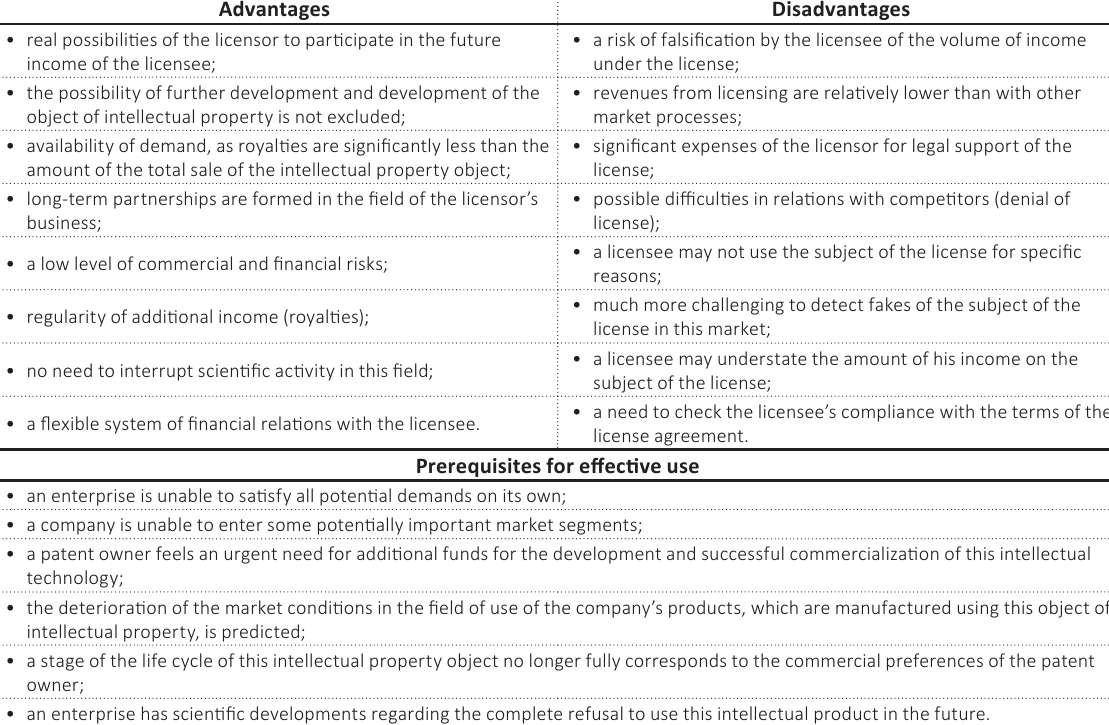
Table 3. Economic characteristics of vertical-horizontal commercialization of intellectual property